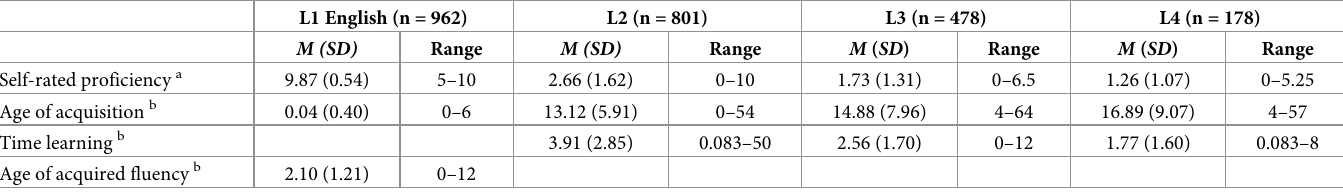
Table 1. Means (and standard deviations) for self-rated proficiency, age of acquisition, and time learning L2, L3, and L4, as well as self-rated English proficiency, age of acquisition of English, and age at which English fluency was reached. L1 English (n = 962) L2 (n =